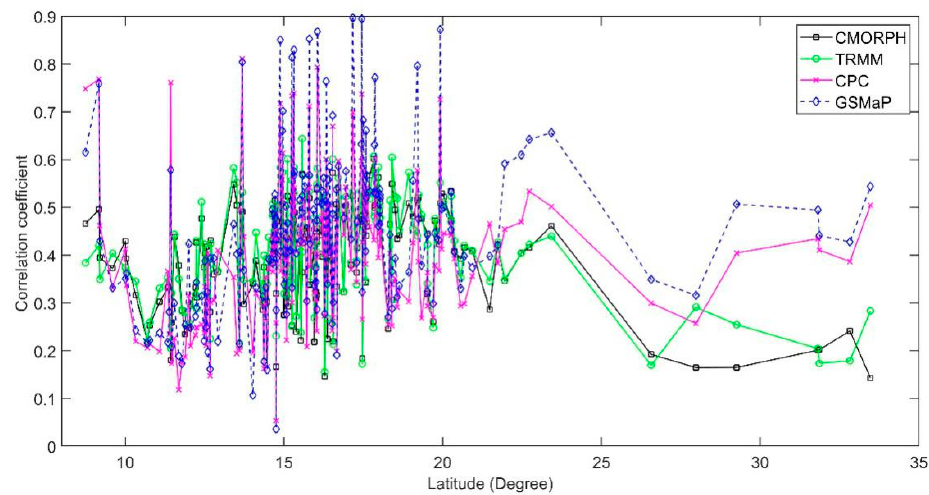
Figure 4. Correlation coe ffi cients of the GPPs and the observed rainfall with latitude.